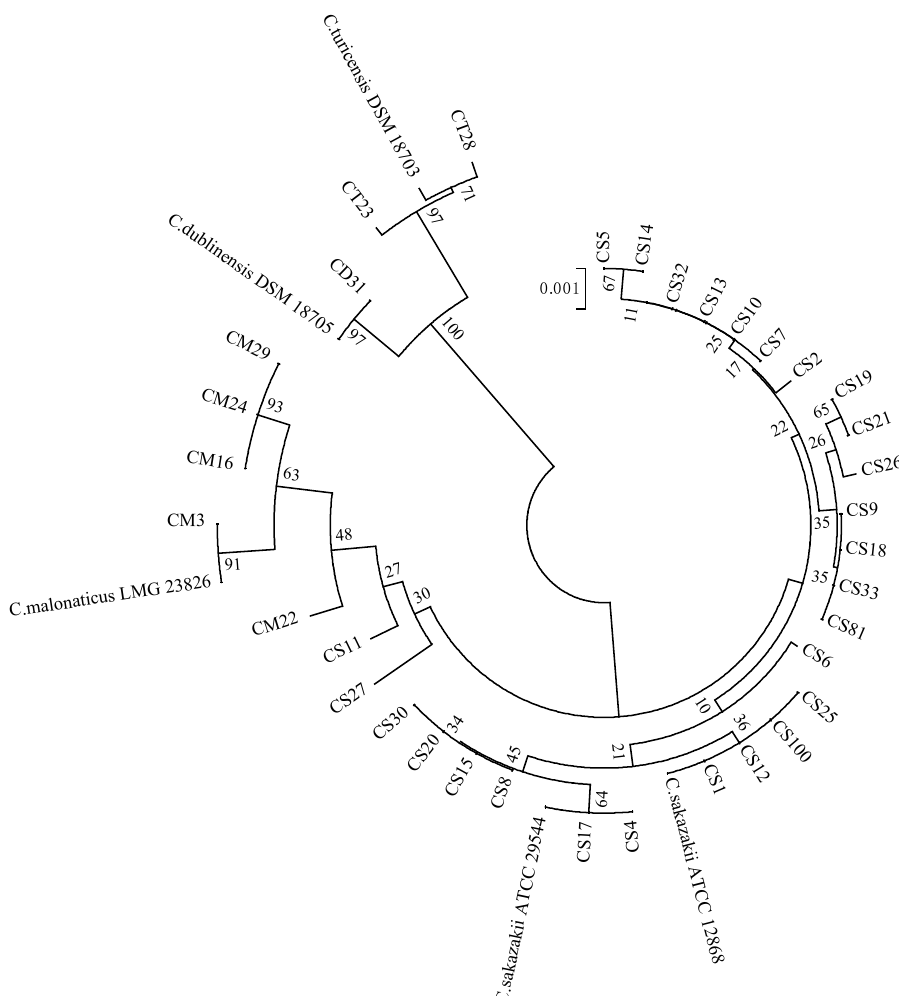
Figure 1. The phylogenetic tree based on 16S rRNA sequences.